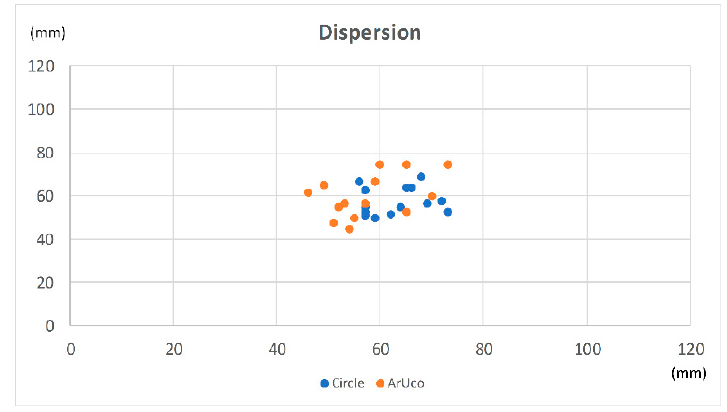
Figure 21. Discrepancy between center coordinates evaluated via circle versus via ArUco markers.